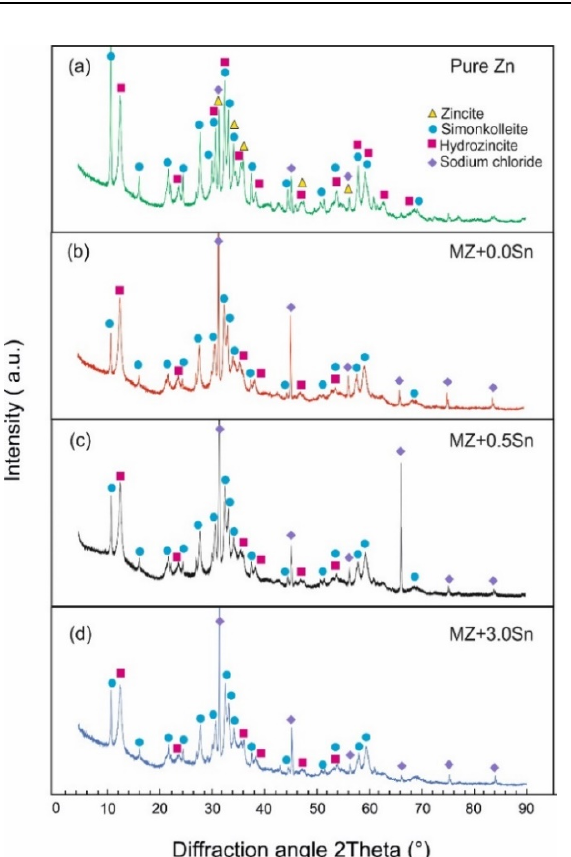
Figure 10. XRD patterns of corrosion product powders retrieved from the as-cast samples after 1000 h of NSST: ( a ) pure Zn ( b ) MZ+0.0Sn ( c ) MZ+0.5Sn ( d ) MZ+3.0Sn.